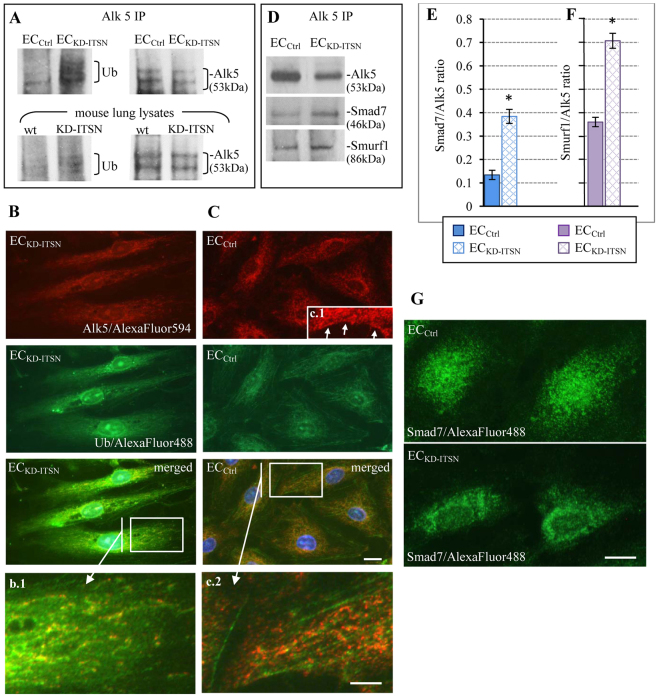

Endocytic deficiency caused by KD-ITSN enhances degradation of Alk5.Endocytic deficiency caused by KD-ITSN enhances degradation of Alk5. (A) Lysates of ECCtrl, ECKD-ITSN, wild-type (wt) and KD-ITSN mice, normalized to 500 µg of total protein, were subjected to immunoprecipitation (IP) using the anti-Alk5 antibody. Western blotting using a ubiquitin (Ub)-specific antibody shows significant ubiquitylation of Alk5 in ITSN-deficient specimens. Anti-Alk5 pulls down Alk5 in controls and KD-ITSN samples; however, Alk5 amounts are ∼40% lower in KD-ITSN samples, as estimated by densitometry (NIH ImageJ). (B,C) Double immunofluorescence for Alk5 (Alexa Fluor 594) and ubiquitin (Alexa Fluor 488) in ECKD-ITSN and ECCtrl. Panels b.1 and c.1 are magnifications of boxed areas in the merged images from B and C, respectively. Arrows show the labeling of endothelial cell plasma membrane by Alk5 antibody. (D) Lysates of ECCtrl and ECKD-ITSN were subjected to immunoprecipitation with an Alk5-specific antibody, followed by western blotting for Alk5, Smad7 and Smurf1. Note the decreased Alk5 immunoreactivity in ECKD-ITSN compared with that of ECCtrl. (E,F) Densitometry of Alk5, Smad7 and Smurf1 immunoreactivity. Values are shown as the mean±s.e.m. of the ratios Smad7:Alk5 (blue bars) and Smurf1:Alk5 (purple bars); *P<0.05 versus controls. (G) ECCtrl and ECKD-ITSN subjected to Smad7 (Alexa Fluor 488) fluorescent staining. Scale bars: 20 µm (B,C,G); 10 µm (b.1, c.2). All data are representative of least three independent experiments.